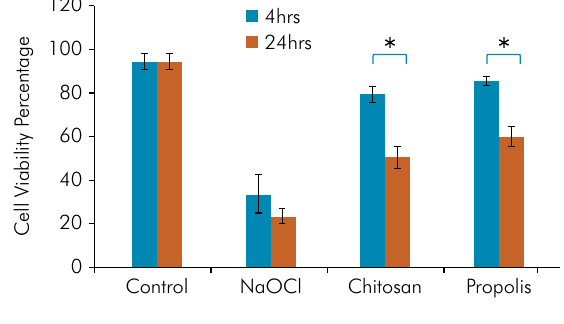
Figure 2. Changes in cell viability after 4 and 24 h exposure of groups of solutions. Values represent mean and SD of three independent experiments.p < 0.05; *Statistically significant differences between